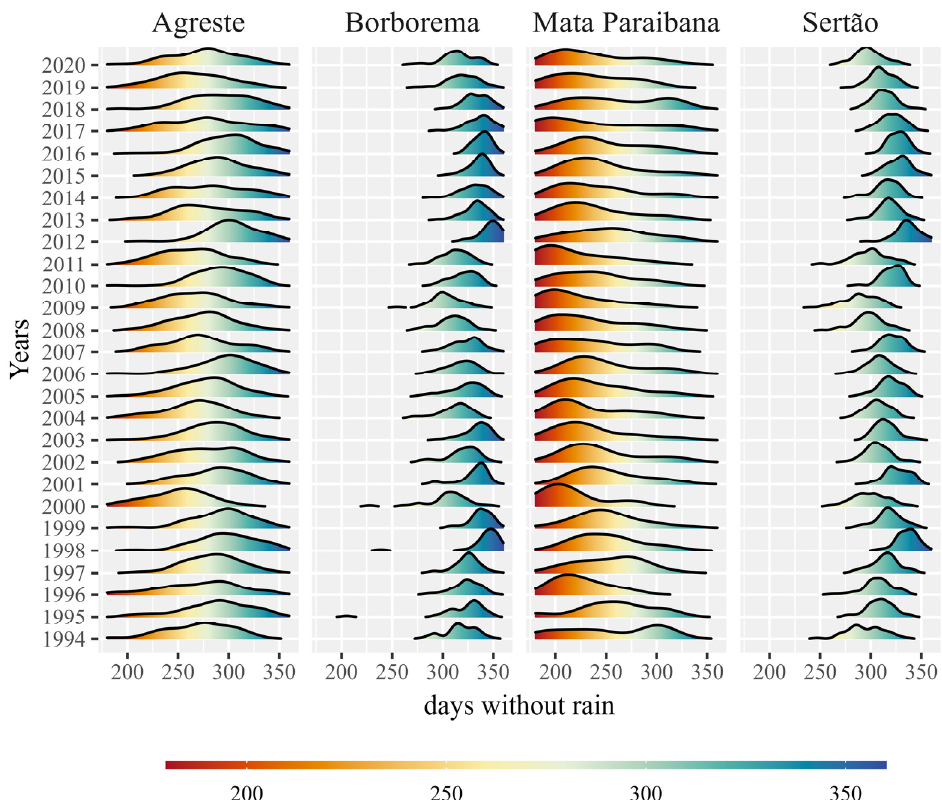
Figure 3. Density of the annual number of days without rain (DWR) for the Paraíba mesoregions from 1994 to 2020.